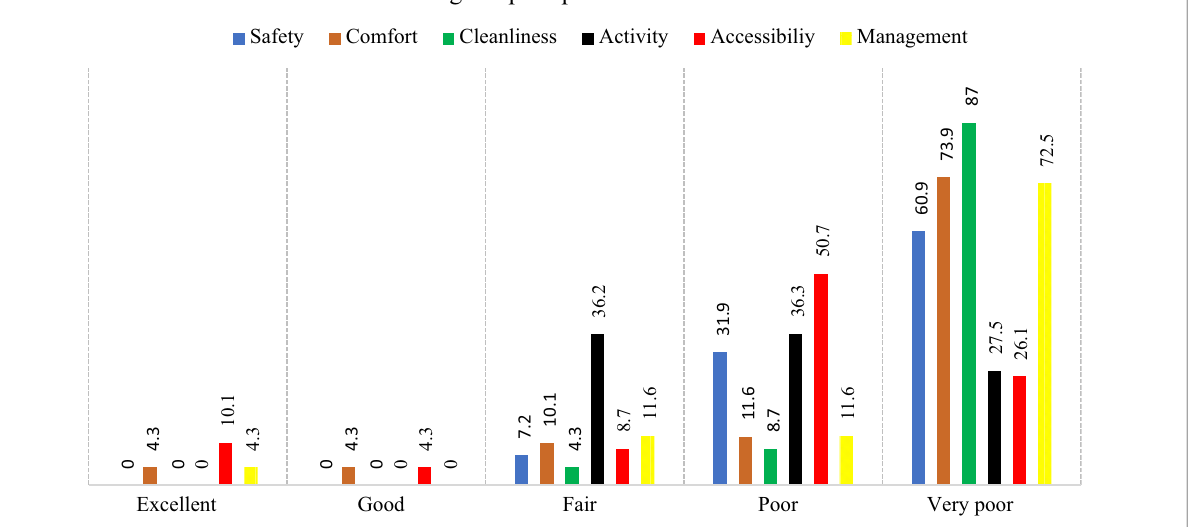
Fig. 8 Overall rating of condition of open spaces at Kebena